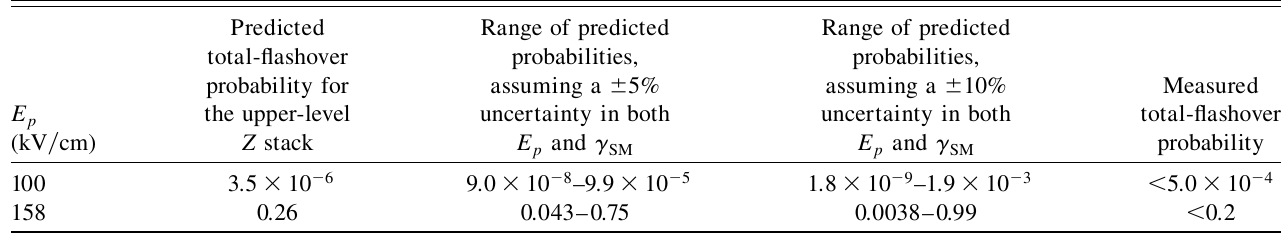
TABLE II. Comparison of total-stack-flashover predictions with measurements for the upper-level Z -accelerator insulator stack. The stack consists of five 45 (cid:1) 5.72-cm-thick, 1003-cm-circumference Rexolite insulator rings connected in series. The flashover probabilities account for transit-time and nonuniform-grading effects, and were calculated using the FORTRAN program that can be downloaded as described in [82]. The large ranges in the third and fourth columns are due to the strong dependence of the flashover =(cid:24) probability on the ratio E p SM